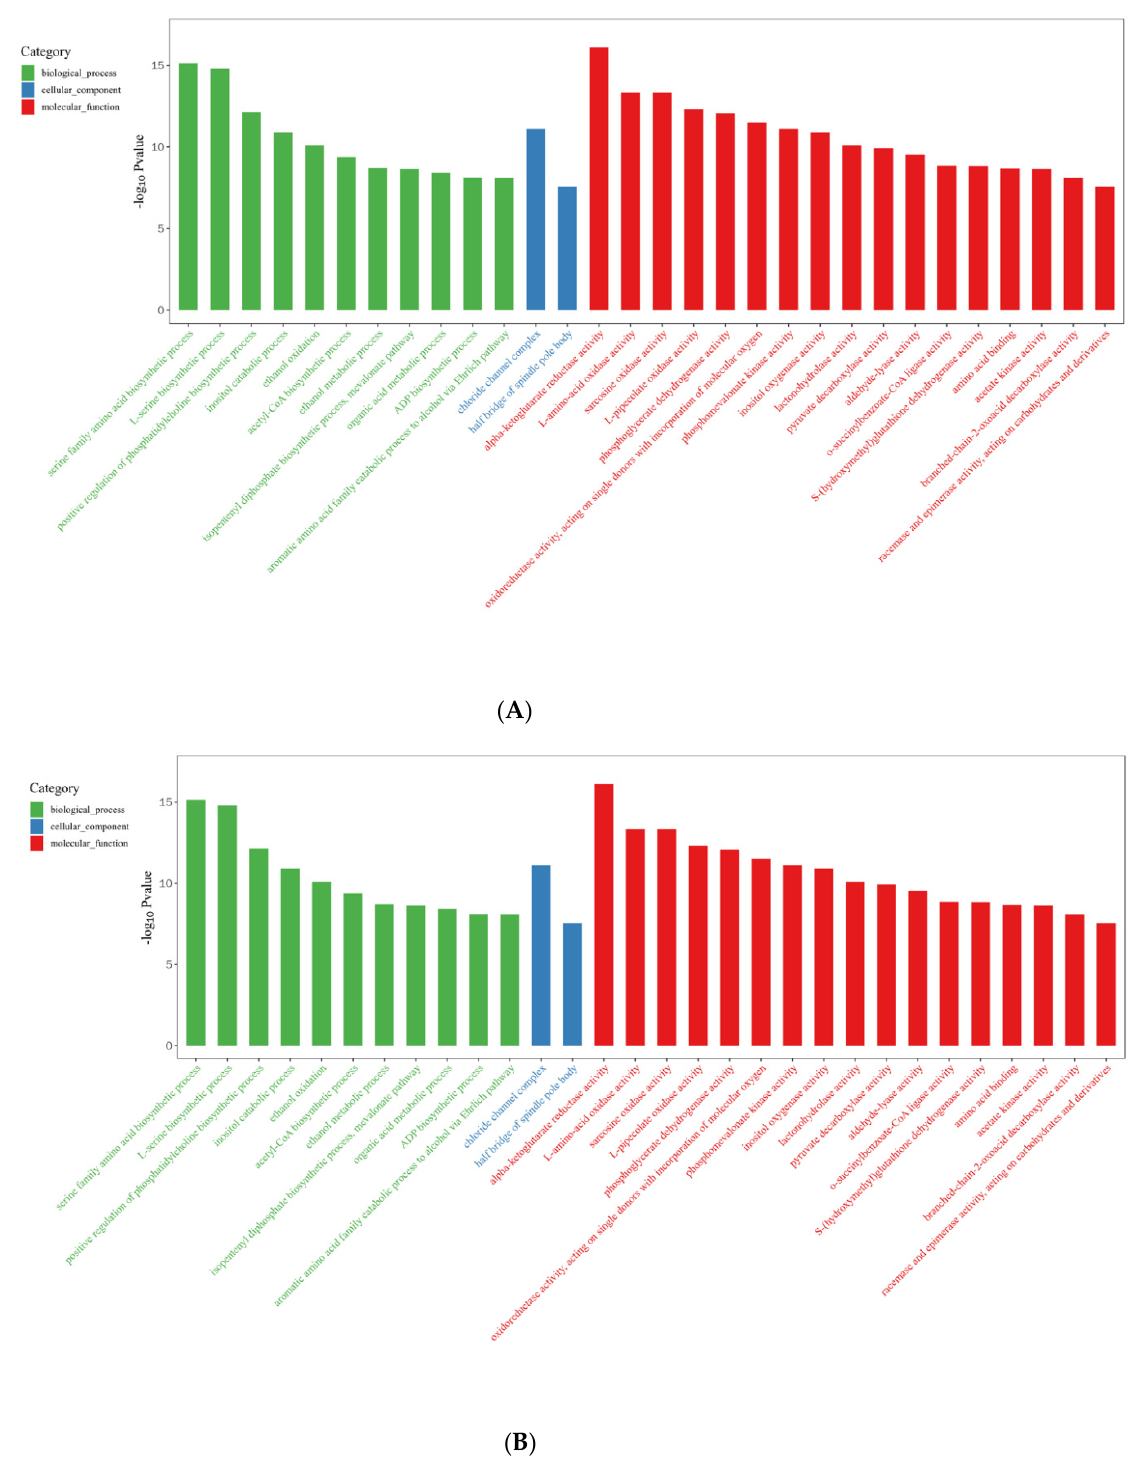
Figure 7. Gene Ontology (GO) database enrichment analysis of DEGs in primordium between blue light and red light. ( A ). DEGs upregulated under blue light. ( B ) . DEGs upregulated under red light.